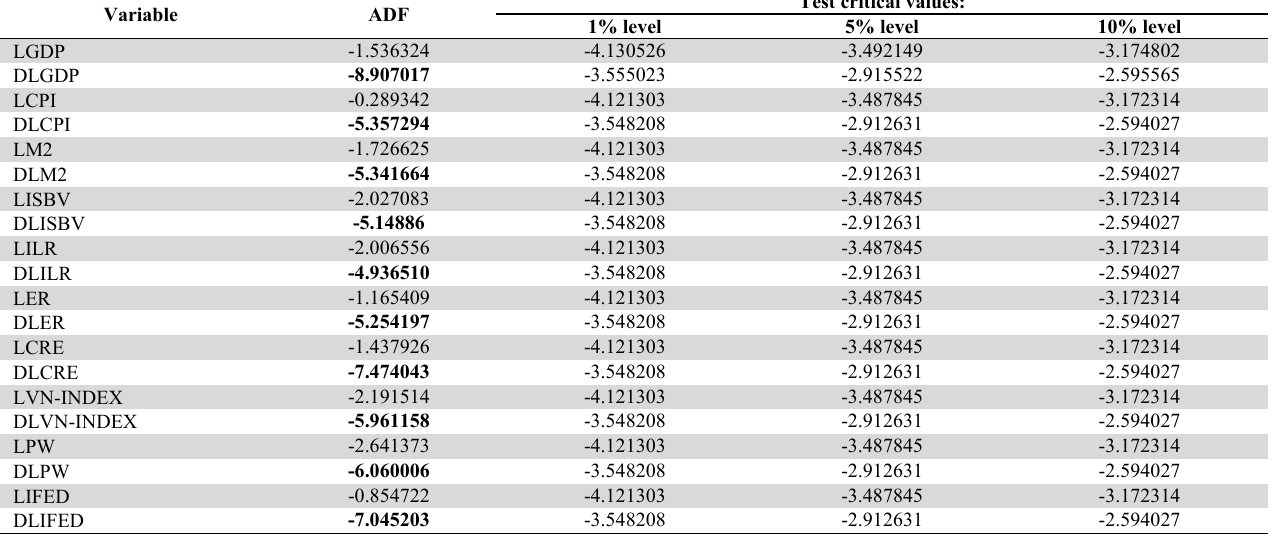
Source: Result of the model